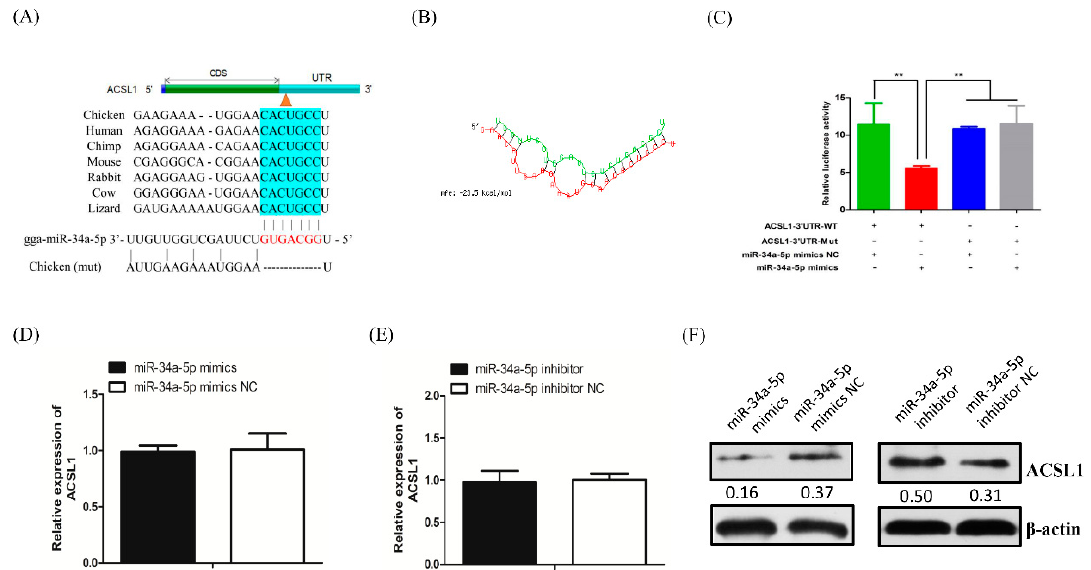
Figure 3. Validation of the ACSL1 gene as a direct target of miR-34a-5p. ( A ) Complementary sequences of miR-34a-5p and the 3 (cid:48) UTR of the ACSL1 gene among species. Red indicates the seed region of miR-34a-5p; blue indicates the target 3 (cid:48) UTR of ACSL1 gene; ( B ) secondary structure of the RNA duplex of miR-34a-5p and the 3 (cid:48) UTR of the ACSL1 gene. Red indicates the target 3 (cid:48) UTR of the ACSL1 gene; green indicates miR-34a-5p; ( C ) validation of the interaction between miR-34a-5p and the ACSL1 3 (cid:48) UTR by a dual-luciferase reporter system. Data are presented as mean ± SD ( n = 3); ( D ) qRT-PCR analysis of ACSL1 mRNA abundance in LMH cells treated with miR-34a-5p mimics and control; ( E ) qRT-PCR analysis of ACSL1 mRNA in LMH cells treated with miR-34a-5p inhibitor and control; ( F ) Western blotting analysis of ACSL1 protein abundance in LMH cells treated with miR-34a-5p mimics, inhibitor and controls. The digit means the gray value ratio of the target band and the internal reference band. Data are presented as mean ± SD ( n = 6) * p < 0.05, ** p < 0.01.